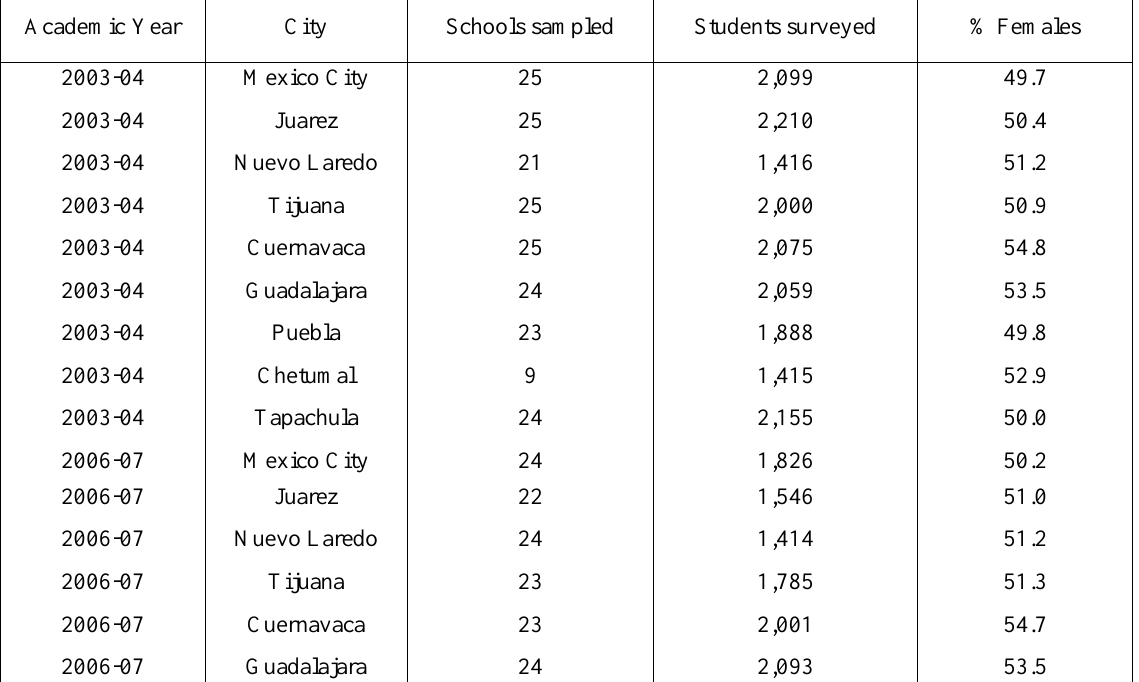
Table 1. Study population. GYTS Mexico 2003-2004 and